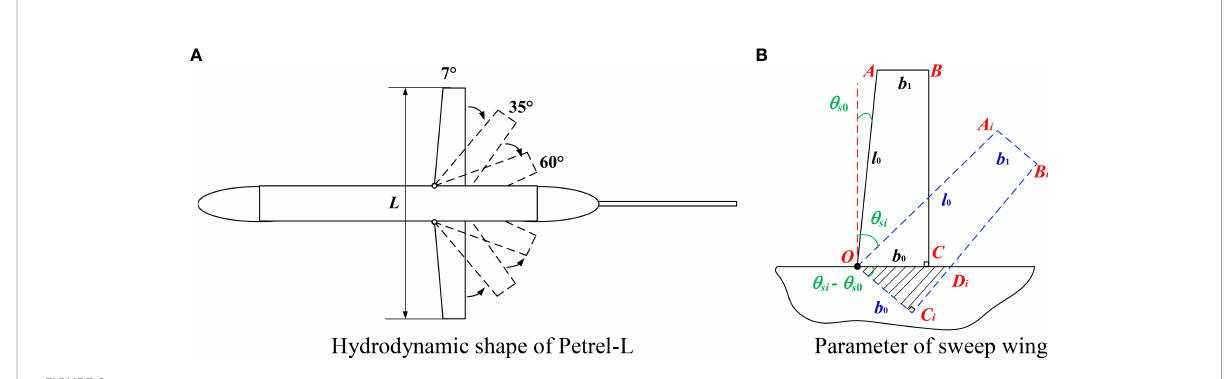
FIGURE 2 Hydrodynamic shape of Petrel-L with various sweep wings. (A) Hydrodynamic shape of Petrel-L (B) Parameter of sweep